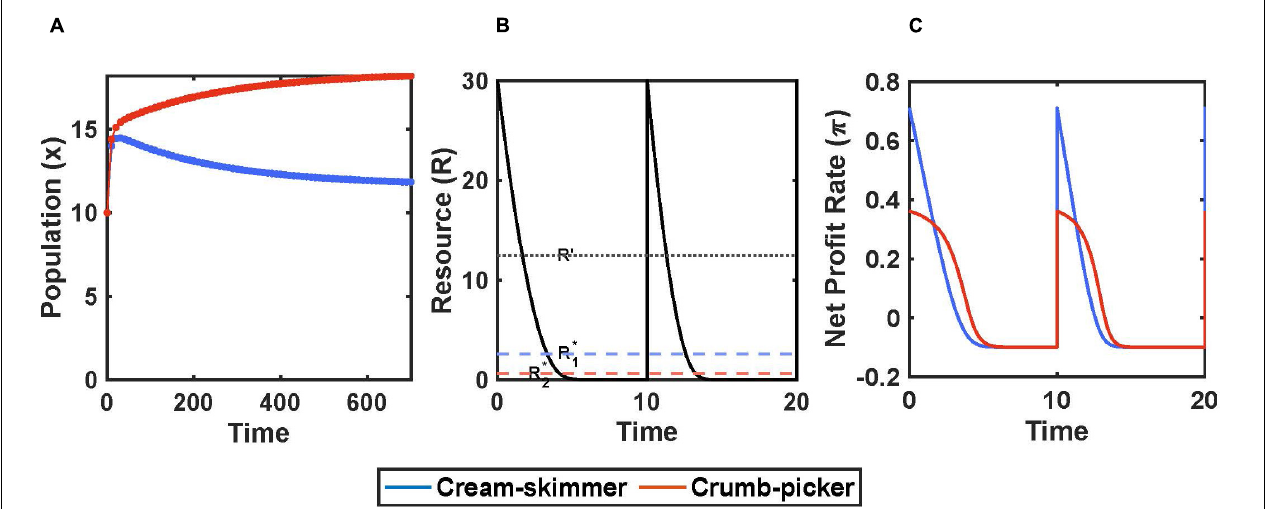
FIGURE 2 | Encounter rate and handling time trade-off with pulsed resource. (A) Species coexist when R 0 = 30 and µ = 5. (B) There is a pulse of resource every T = 10 units of time. The crumb picker has the lower subsistence level of resource, R * 2 . (C) Net profit rate of consumers in response to pulse of resource. Parameters: a 1 = a 2 / µ , a 2 = 0.2, h 1 = h 2 / µ , h 2 = 2, b 1 = b 2 = 0.7, c 1 = c 2 = 0.1, x 1 (0) = 10, x 2 (0) =